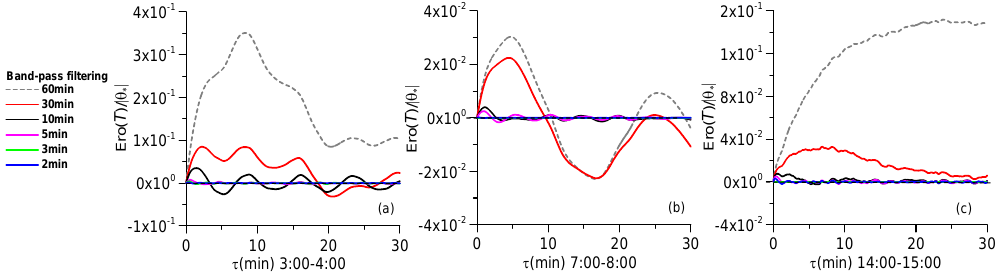
Figure 2. Variation of mean ergodic function Ero( T ) of the different scale eddies of temperature with relaxation time (other conditions are as some as Fig. 2, and the same applies to the following